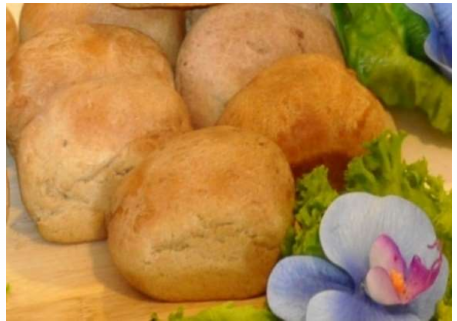
Figure 2. Bread loaves with insect powder addition.